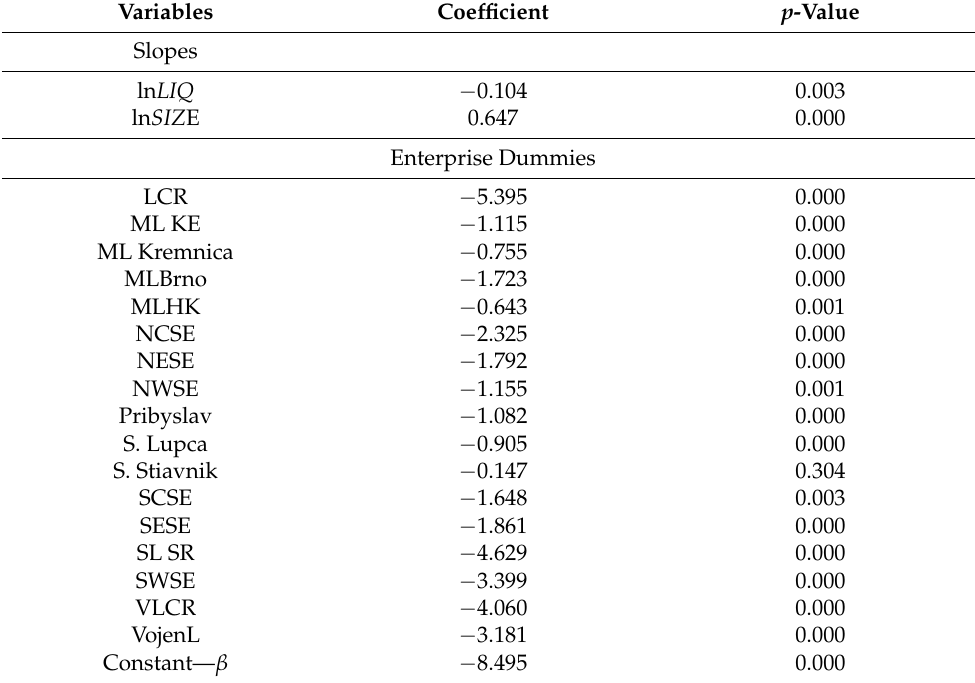
Table 6. Panel data results with omitted insignificant variables for model (1): α =